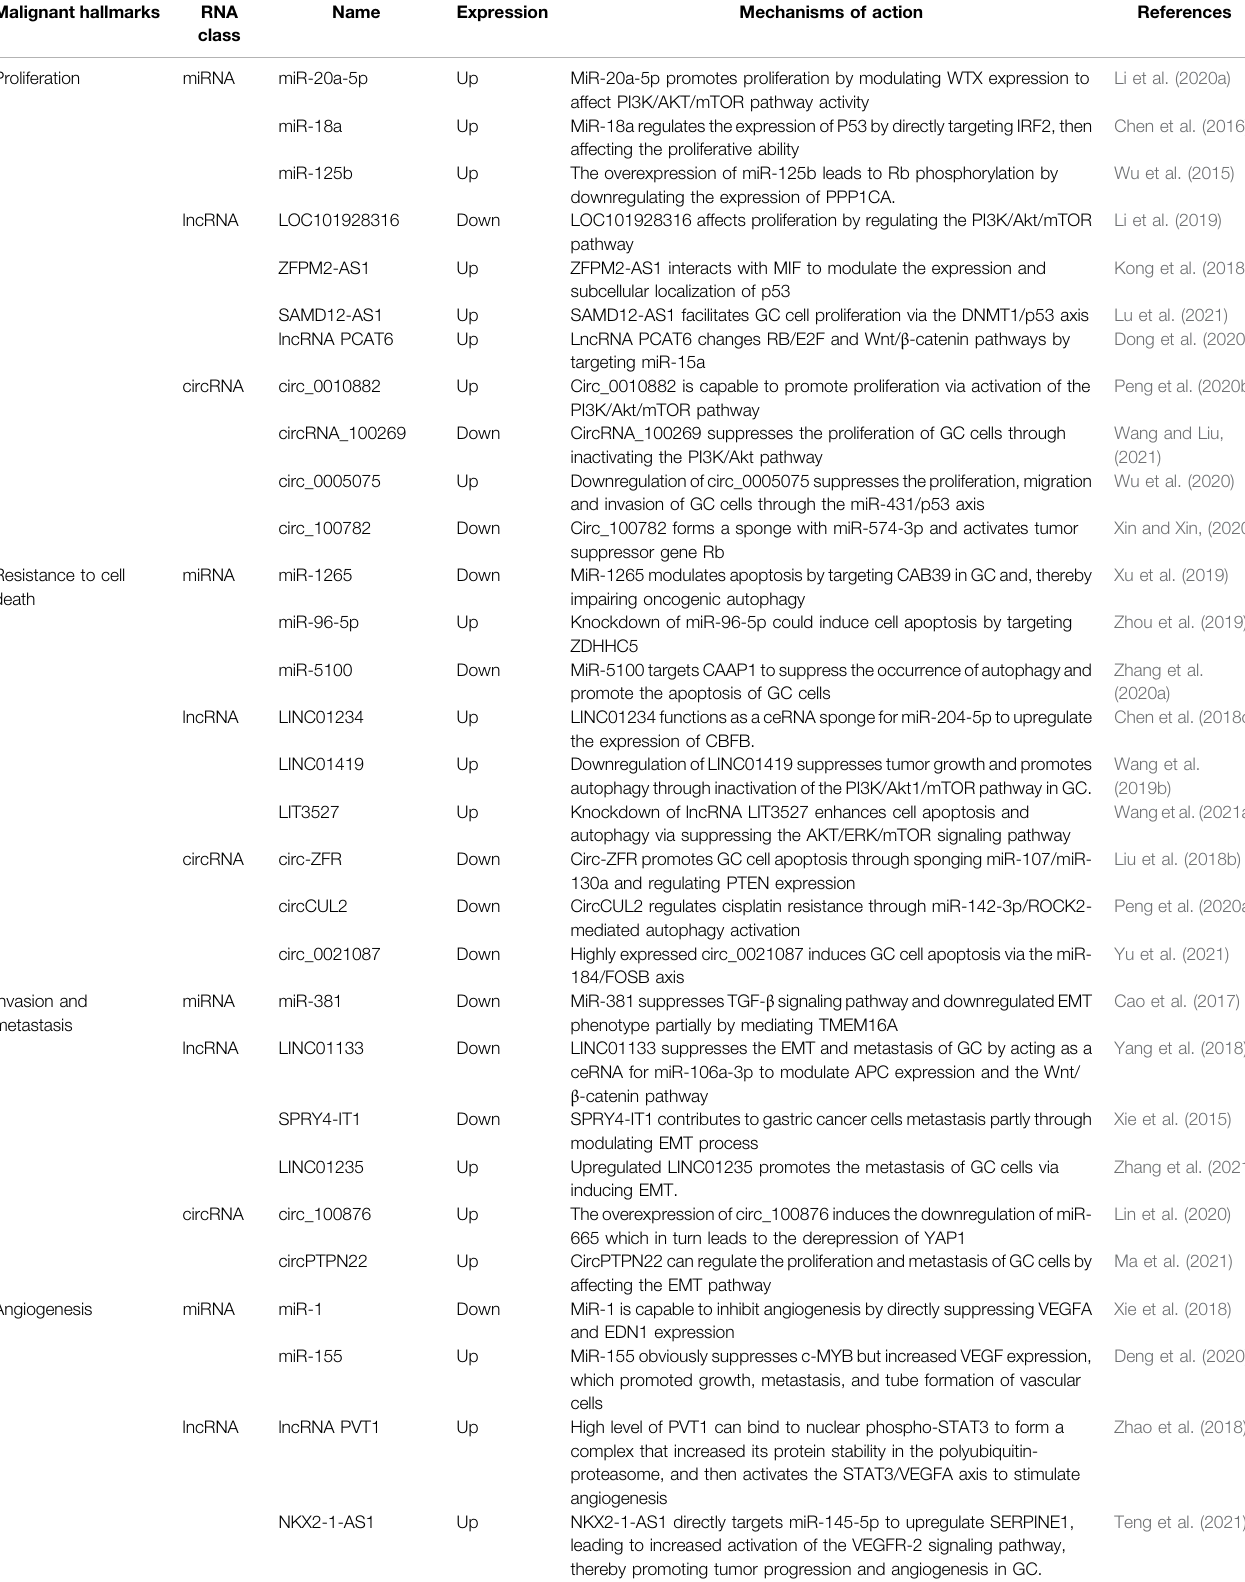
TABLE 1 | The relationship between ncRNAs and the malignant hallmarks of GC. Malignant